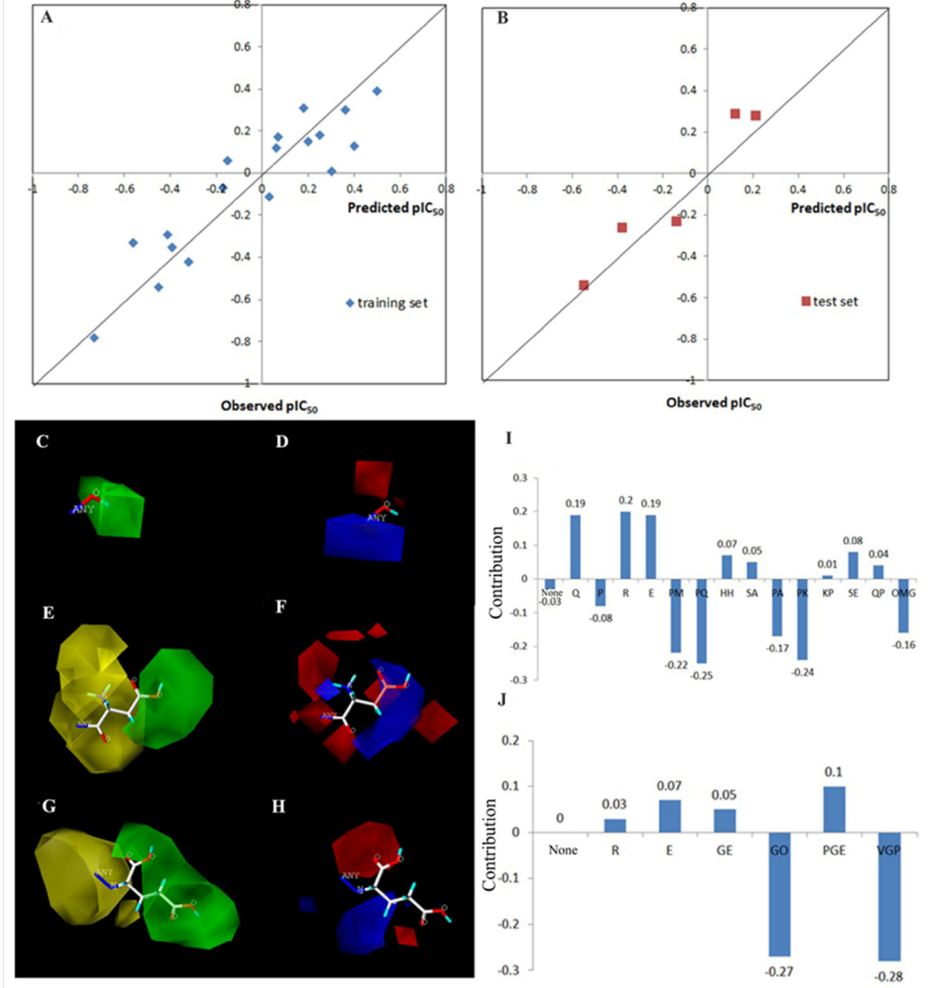
Figure 2. The 3D-QSAR model established by Topomer CoMFA. Plots of predicted values of pIC 50 versus actual values for ( A ) training set (r 2 = 0.862) and ( B ) test set (r 2 = 0.930) of antiplatelet peptides using the Topomer CoMFA model. (C-H) Steric and Electrostatic Contribution maps for tetrapeptides ROGE by Topomer CoMFA analysis. The color of ROGE molecular diagram: White-C, Blue-N, Aquamarine-H, Red-O, Yellow-S. ANY: The sites where the R groups are introduced to the PG common skeleton. ( C ) Steric Contribution map of R1 group. ( D ) Electrostatic Contribution map of R1 group. ( E ) Steric Contribution map of R2 group. ( F ) Electrostatic Contribution map of R2 group. ( G ) Steric Contribution map of R3 group. ( H ) Electrostatic Contribution map of R3 group. ( I ) Total Contribution of C-terminal amino acid residues. ( J ) Total Contribution of N-terminal amino acid